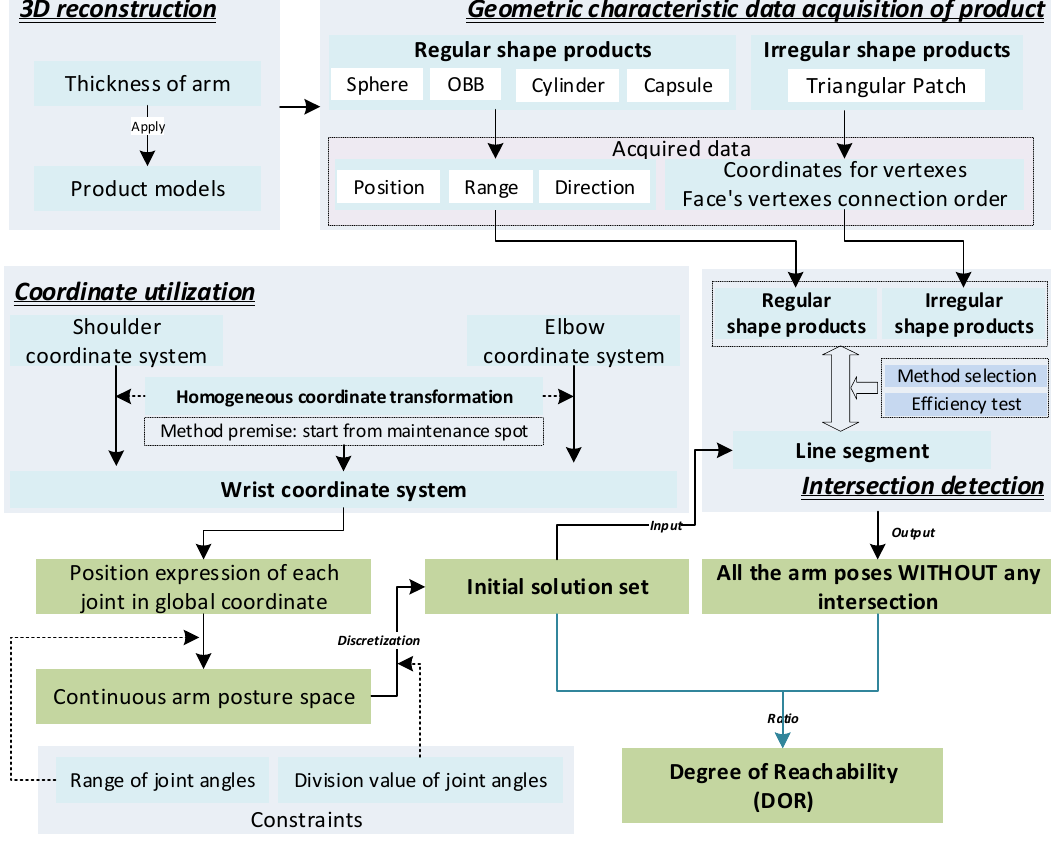
Figure 1. Overall Structure.